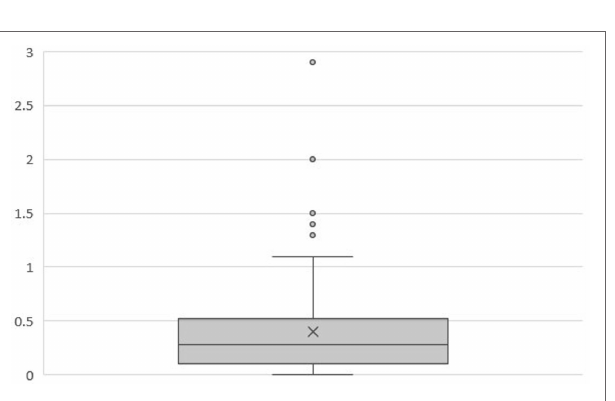
FigUre 2 | Box plot illustrating the distribution of PSA values (ng/ml) at 5 years in patients without biochemical relapse ( n = 128). Mean = 0.40. Median = 0.28. Q 1 = 0.1. Q 3 = 0.52.